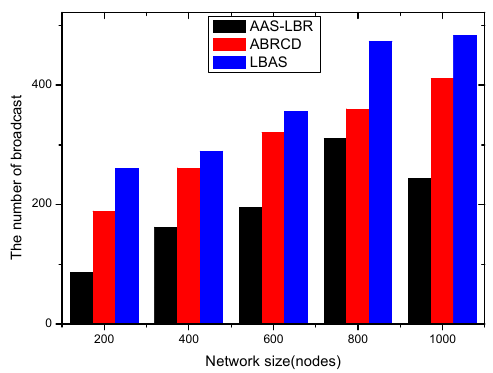
Figure 38. The impact of network size with fixed |𝑇| = 90 on the number of broadcasts.